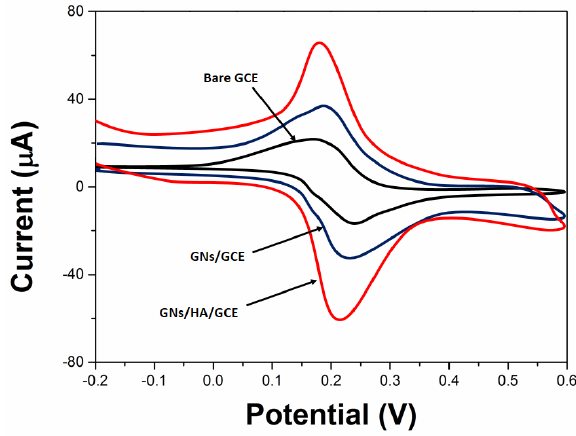
Figure 2. Cyclic voltammograms (CVs) of 1 mM K 3 [Fe(CN) 6 ] + 0.1 M HCl on bare glassy carbon electrode (GCE), GNs/GCE and GNs/HA/GCE. Scan rate: 50 mV/s.